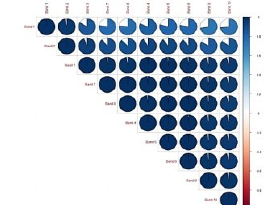
Figure5: Correlogram of sentinel-2A bands used in the study. (Solid ellipse and darker blue show higher